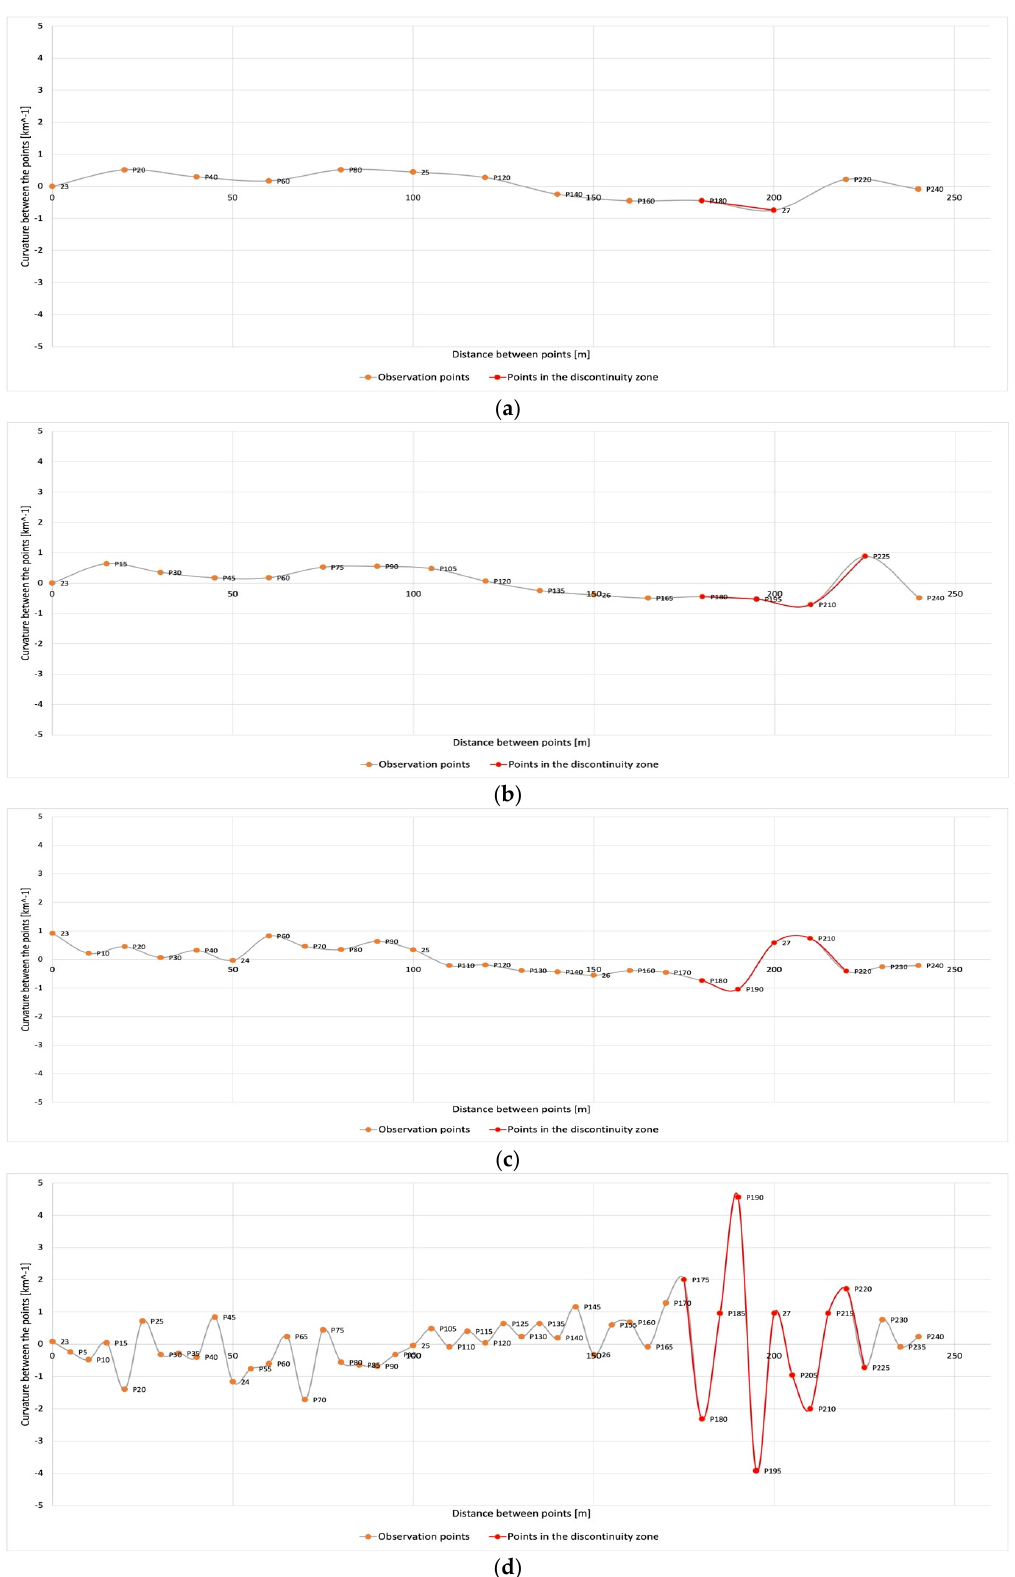
Figure 19. Curvature (K) graphs between measurement points at a distance of ( a ) 20 m, ( b ) 15 m, ( c ) 10 m and ( d ) 5